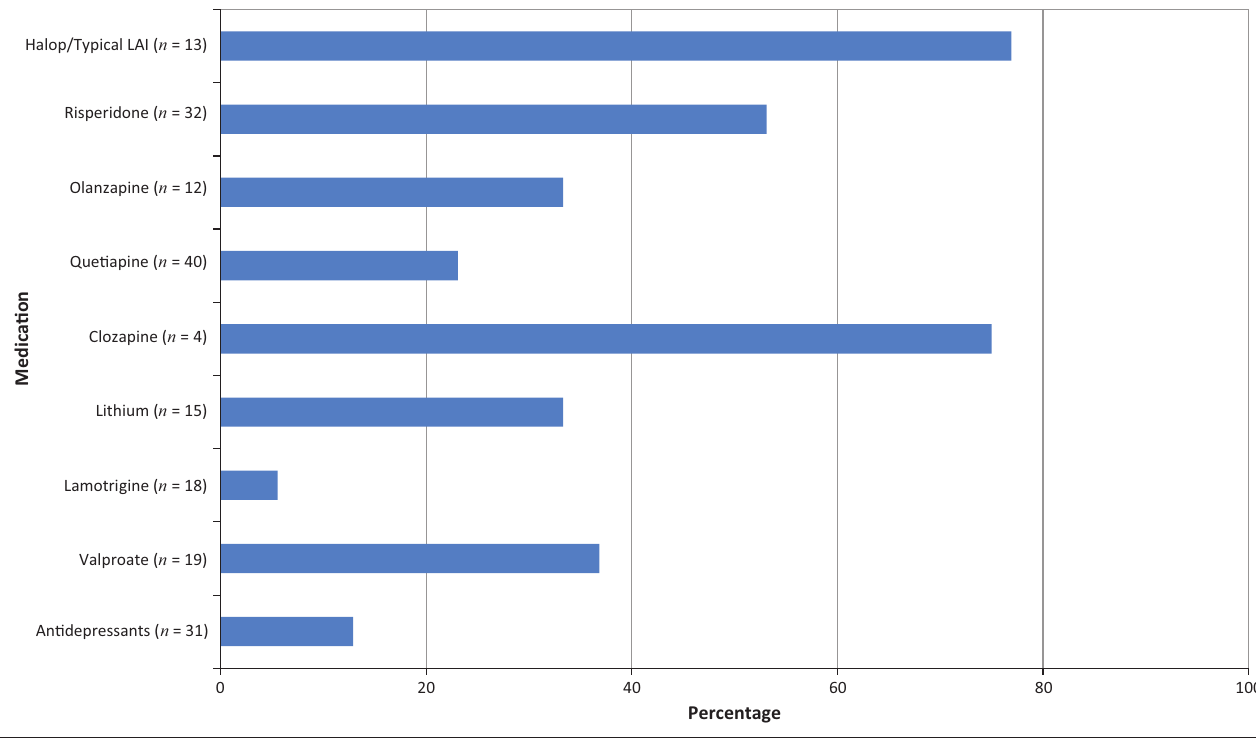
LAI, long acting injectable. FIGURE 2: Percentage of patients on a medication who reported side